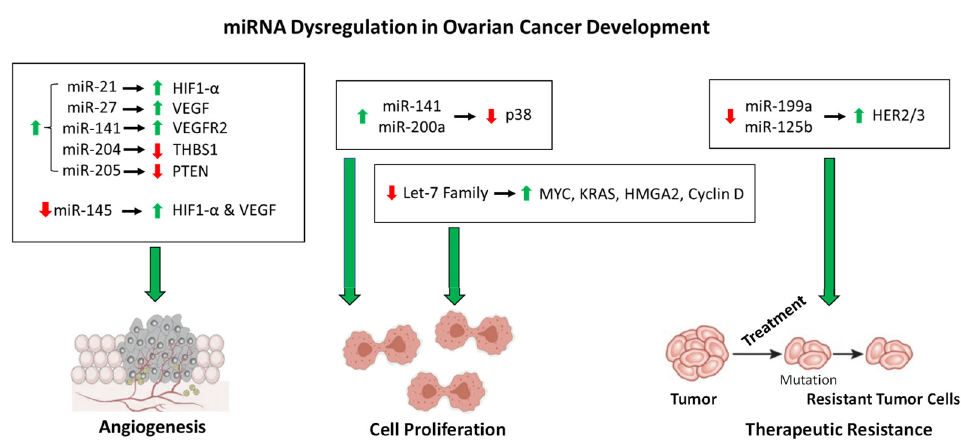
Table 2. miRNAs downregulated in OC cells that function as tumor suppressors. miRNA Target mRNA(s)/Function Ref Let-7 Family KRAS, c-MYC /Tumor suppression through KRAS and c-MYC downregulation. miR-31 CDKN2A /Tumor suppression through CDKN2A downregulation. miR-125b VEGF, HER3, HIF1- α /Tumor suppression through VEGF , HER3 and HIF1- α downregulation. miR-135a CCR2 /Tumor suppression through CCR2 degradation. miR-145 P70S6K1 /Tumor suppression through P70S6K1 downregulation. miR-181 RTKN2 /Tumor suppression through RTKN2 downregulation. miR-199a HER3 /Tumor suppression through HER3 downregulation. miR-200b/200c DNMT3A/3B /Tumor suppression through DNMT3A/3B downregulation. miR-206 c-MET /Tumor suppression through c-MET downregulation. miR-298 EZH2 /Tumor suppression through EZH2 downregulation. miR-424 CCNE1 /Tumor suppression through CCNE1 downregulation. miR-490 CDK1 /Tumor suppression through CDK1 downregulation. miR-508 MAPK1 /Tumor suppression through MAPK1 downregulation.